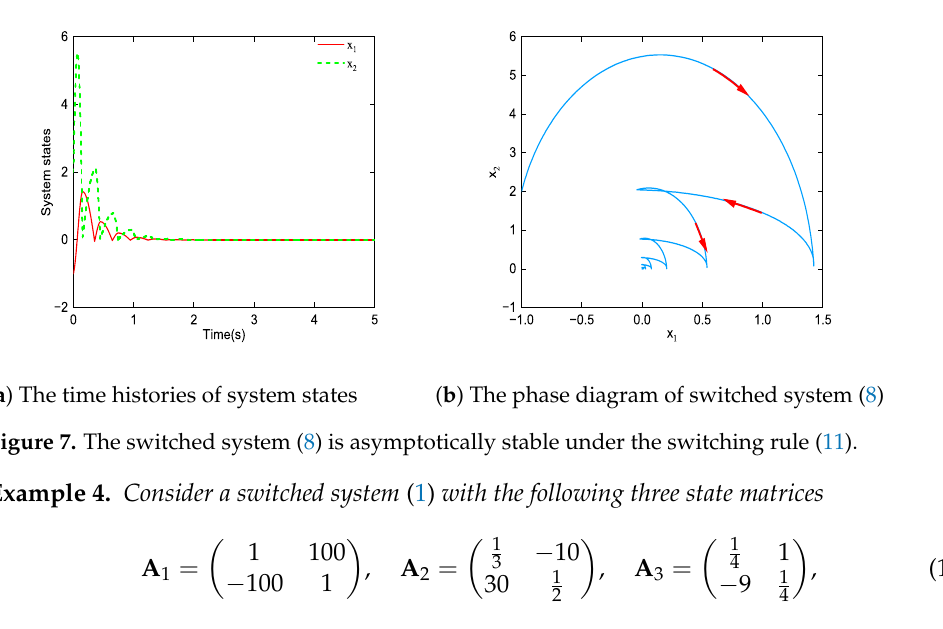
where the initial condition is x ( 0 ) = ( 2, 4 ) T .